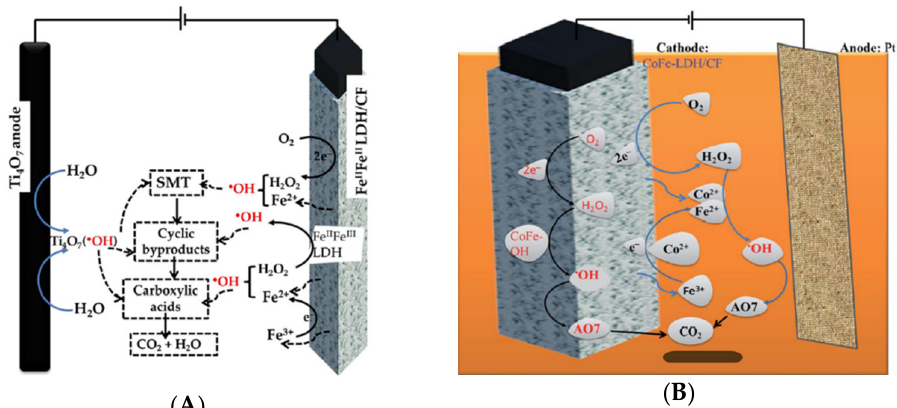
Figure 8. Scheme of two-dimensional electrochemical reactor using carbon felt coated with layered double hydroxides (LDH) with ( A ) Fe(III) and Fe(II) incorporated in the lattice for degradation of sulfamethoxazole [88] or ( B ) Cu(II) and Fe(III) incorporated in the lattice for degradation of orange II [89] along with respective mechanism proposed for degradation of pollutants. Reprinted from [88] with permission from Elsevier (License Number 5172361206614) and [89] with permission from Royal Society of Chemistry (Order License ID 1155310-1).